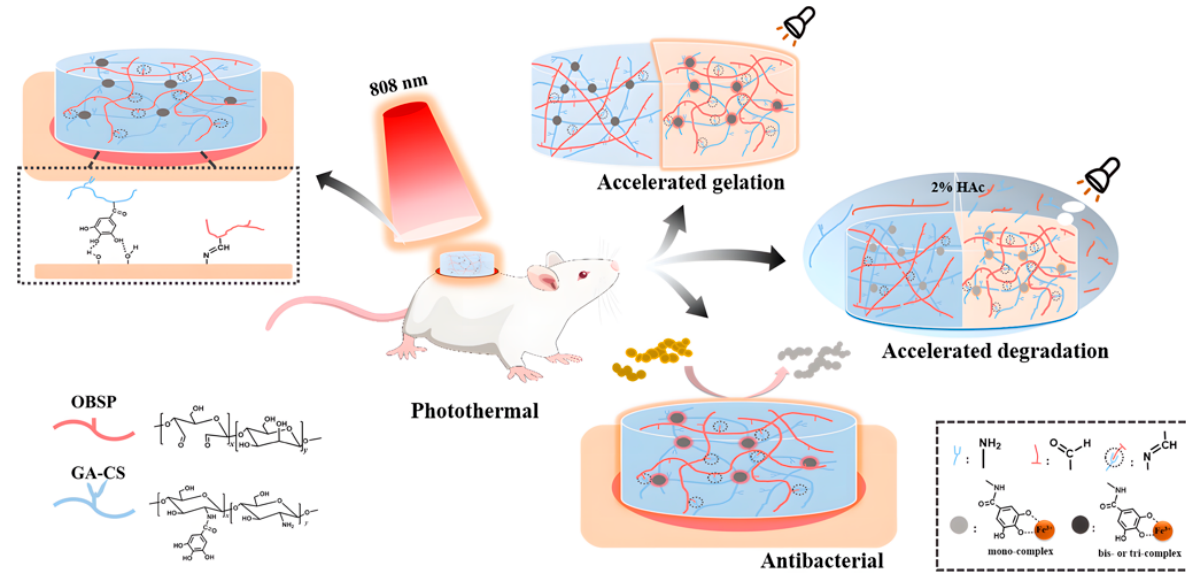
Figure 2. A schematic diagram of the dual network polysaccharide hydrogel and photothermal effect accelerated the gelation and degradation rate of the hydrogel and gallic acid with Fe 3+ showed good antibacterial properties. OBSP: oxidized Bletilla striata polysaccharide; GA-CS: gallic acid grafted chitosan [66]. Reproduced with permission from Chonghao Chen, Carbohydrate Polymers; published by Elsevier, 2021.